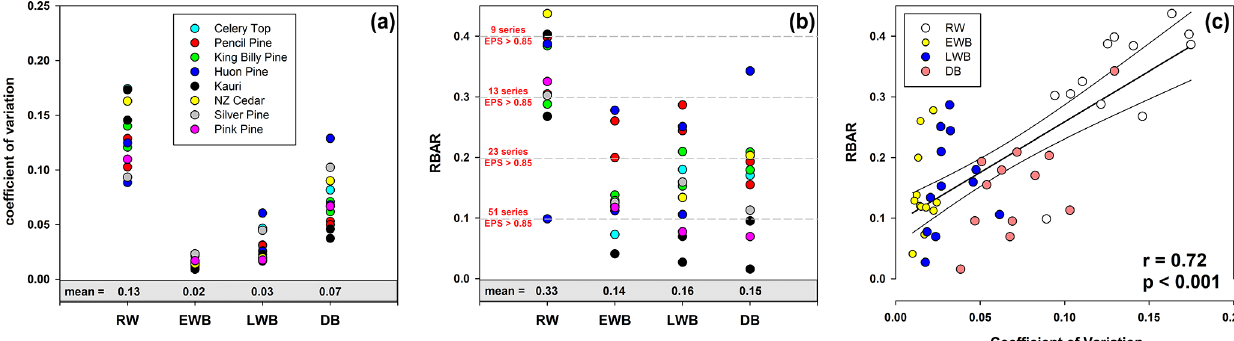
Figure 2. (a) Coefficient of variation (CV) of the 20-year spline detrended chronologies; (b) mean inter-series correlation (RBAR) of the 20-year spline detrended series. Horizontal dashed lines denote the number of series needed for that particular RBAR value to attain an EPS of 0.85; (c) scatter plot of CV versus RBAR with linear